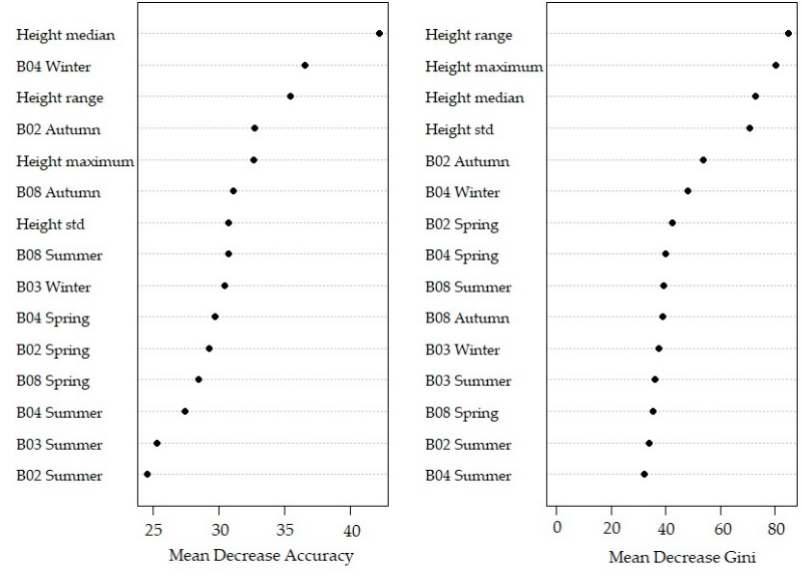
Figure 7. Variable importance plot of the random forest of all variables on phylum level.